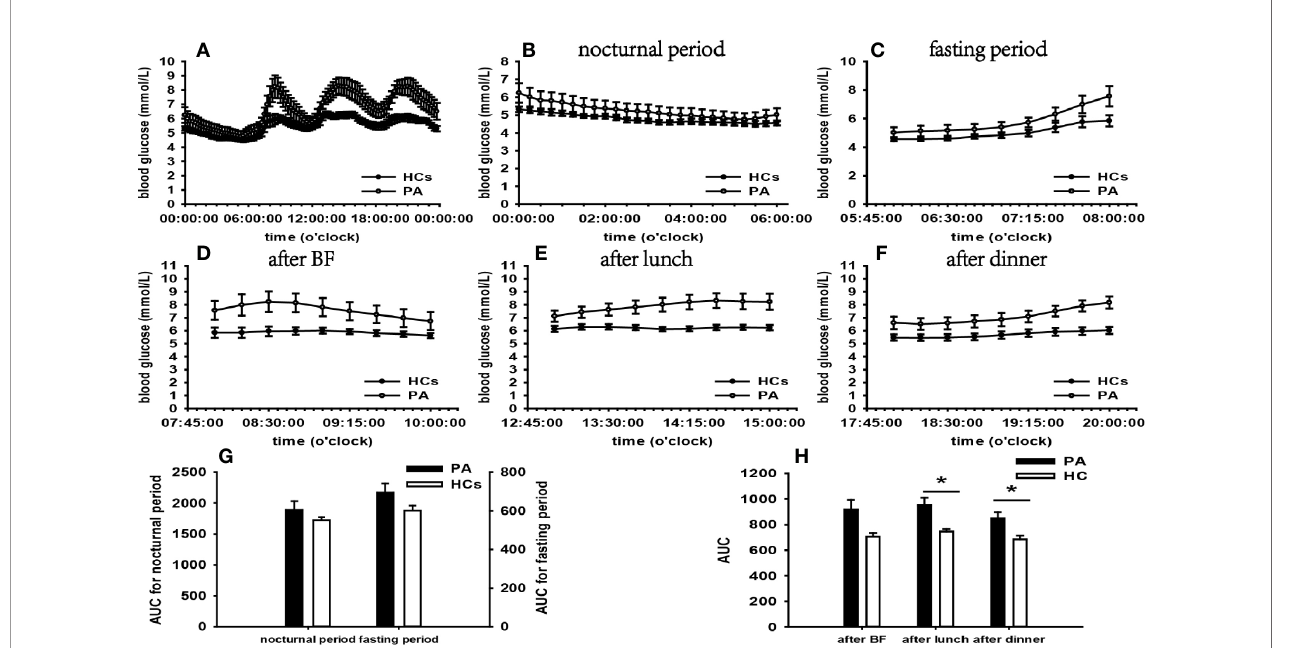
FIGURE 3 | Comparison of the mean blood glucose level and AUC between the PA group and HCs. Mean blood glucose level: (A) at each time point during the day; (B) at nocturnal period; (C) at fasting period; (D) after BF; (E) after lunch; (F) after dinner. AUC: (G) at nocturnal and fasting periods; (H) at postprandial periods. * represents signi fi cant difference between PA and HCs. The data showed as mean ± SEM. AUC, area under the curve; PA, primary aldosteronism; HCs, healthy controls; BF, breakfast; SEM, standard error of mean.